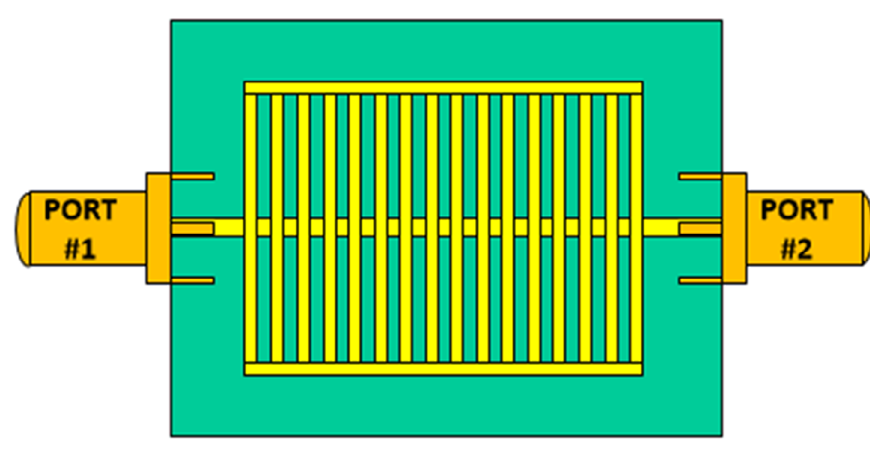
Figure 27. The picture of the device on paper placed on the test cell basement.